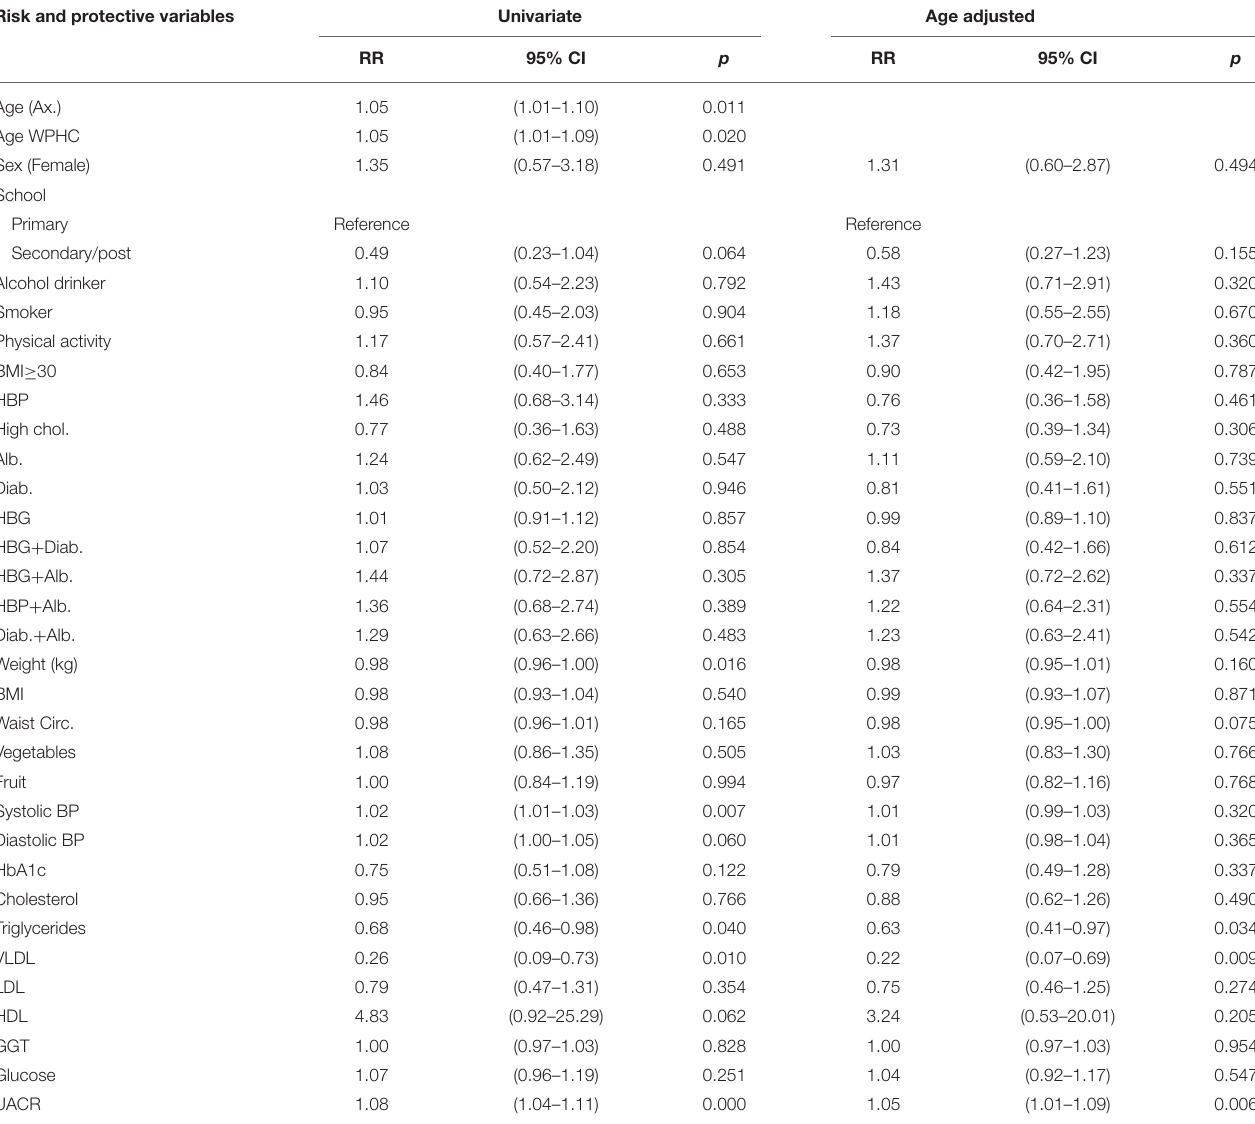
TABLE 2 | Univariate and age adjusted risk ratios (RR) from generalized linear model analyses of earliest risk and protective factors for Cognitive Impairment Not Dementia (CIND) or dementia, among 64 Aboriginal and Torres Strait Islander residents who participated in the Well Person’s Health Check (WPHC) (1998/2000, 2005/2006), by dementia status at follow up